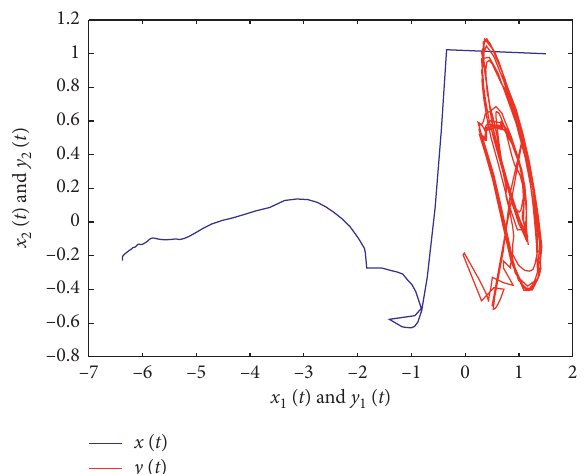
Figure 3: Chaotic attractor of the drive-response system when μ k � 1 . 3.